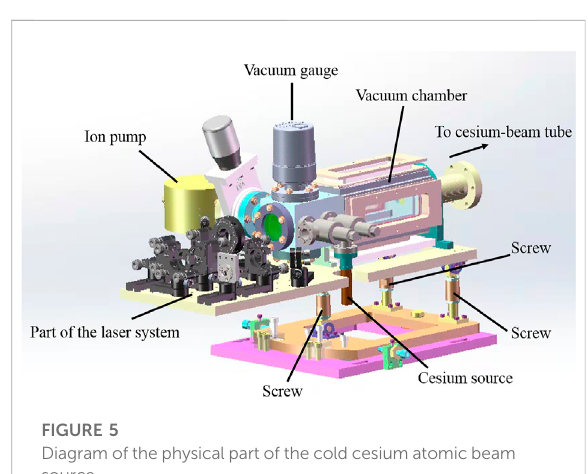
FIGURE 5 Diagram of the physical part of the cold cesium atomic beam